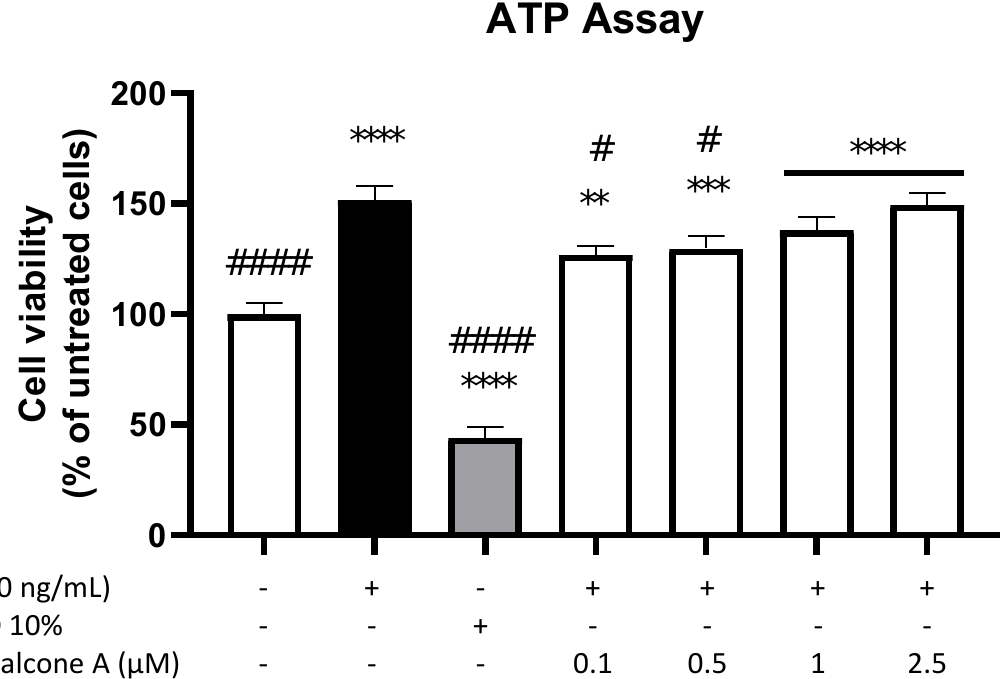
Figure 1. Effects of Licochalcone A on cell viability of primary rat microglial cells. Cells were stimulated as described under materials and methods and, after 24 h, ATP was quantified using the CellTiter-Glo ® Luminescent Cell Viability Assay. Values are presented as the mean ± SEM of at least three independent experiments. Statistical analysis was performed using one-way ANOVA with Dunnett’s post hoc tests with # p < 0.05, ** p < 0.01, *** p < 0.001, and ****/#### p < 0.0001 compared to untreated cells (stars *) and LPS-stimulated cells (hashtags #).